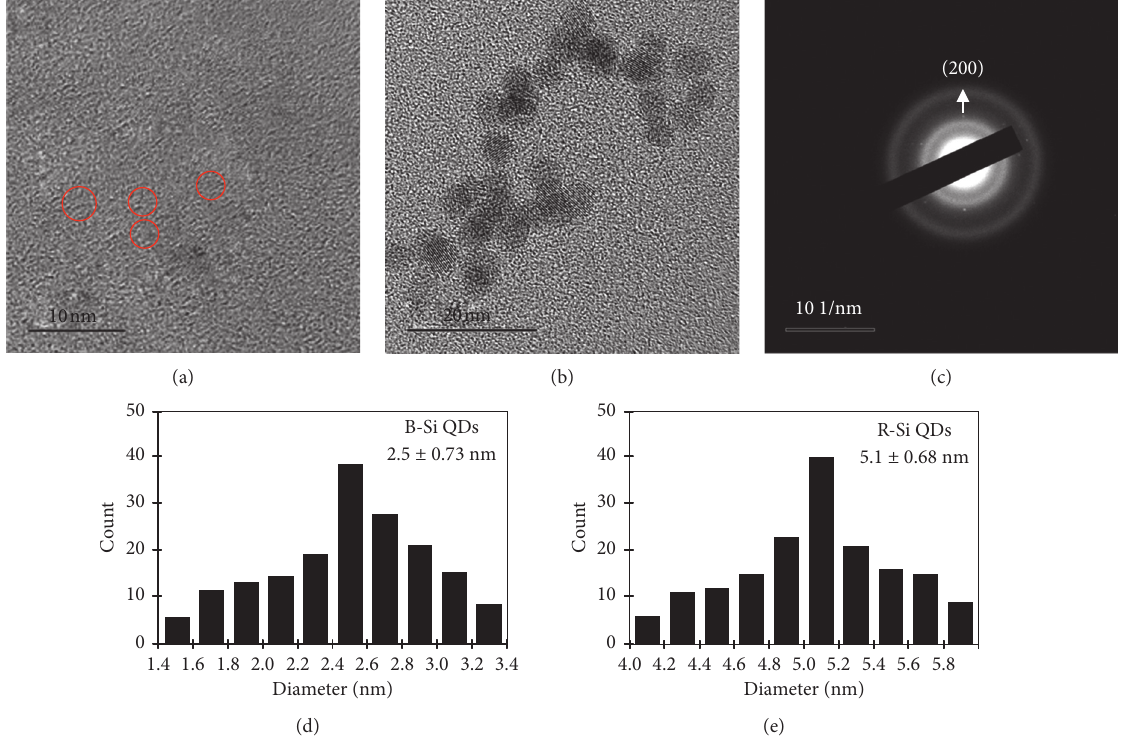
Figure 5: Transmission electron microscopy (FE-TEM): (a-b) selected area electron diffraction (SAED) (c) and size distribution (d-e) of B- Si QDs and R-Si QDs.